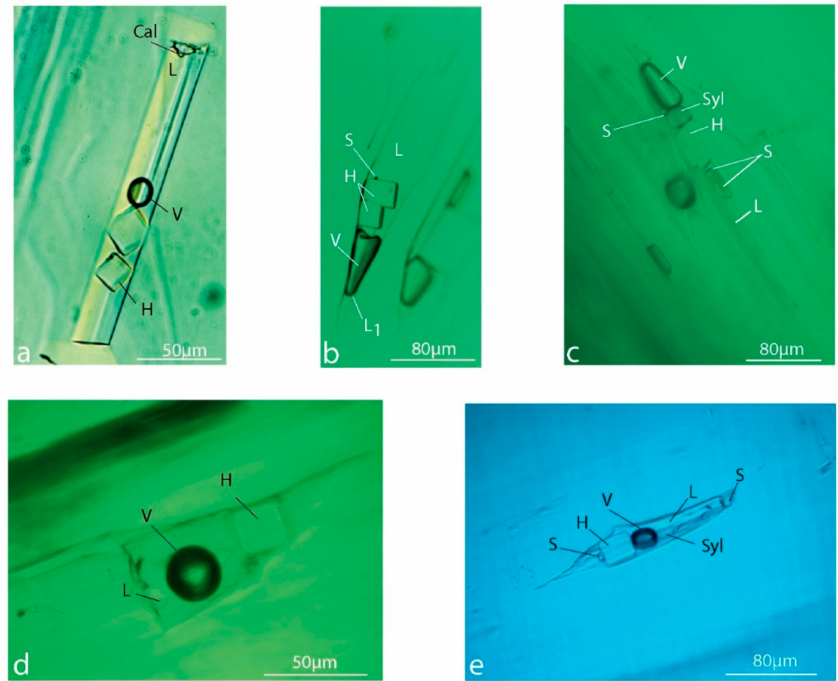
Figure 32. Primary fluid inclusions in emeralds: ( a ) Colombian fluid inclusion presenting a jagged and shredded outline. The cavity contains 75 vol.% of salted water solution (L), 10 vol.% of gas corresponding to the vapour bubble (V), 15 vol.% of halite (NaCl) daughter mineral, and a crystal of carbonate (Ca); ( b ) fluid inclusion in a Colombian emerald showing three cubes of halite (H), the liquid phase (L), the contracted vapour phase (V), a minute black phase (S), and a thin rim of liquid carbon dioxide (L 1 ) rim visible at the bottom part of the vapour phase; ( c ) multiphase fluid inclusions from Panjsher emerald (Afghanistan). They contain vapour and liquid phases (V + L), a cube of halite